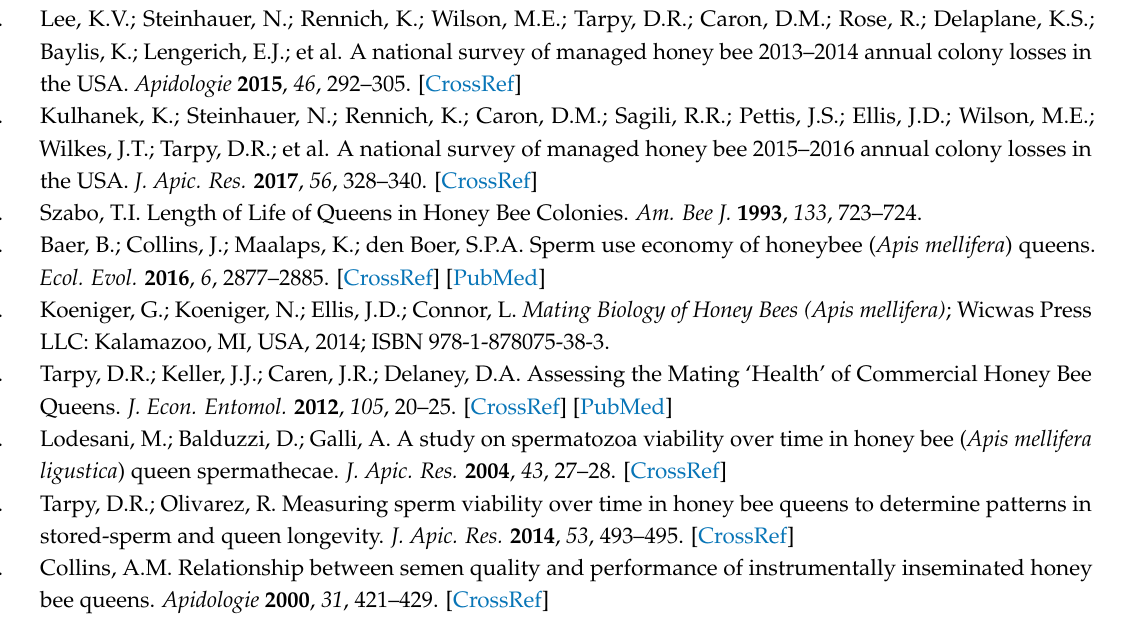
Table S1: Pesticide summary for good-brood and poor-brood colonies in 2016 and 2017, Figure S1: The relative percent of pesticide classes found in beeswax samples from 2016 and 2017, and Supplementary Materials Dataset 1: S1a. Data 2016, S1b. Pesticides 2016, S1c. Data 2017, S1d. Pesticides